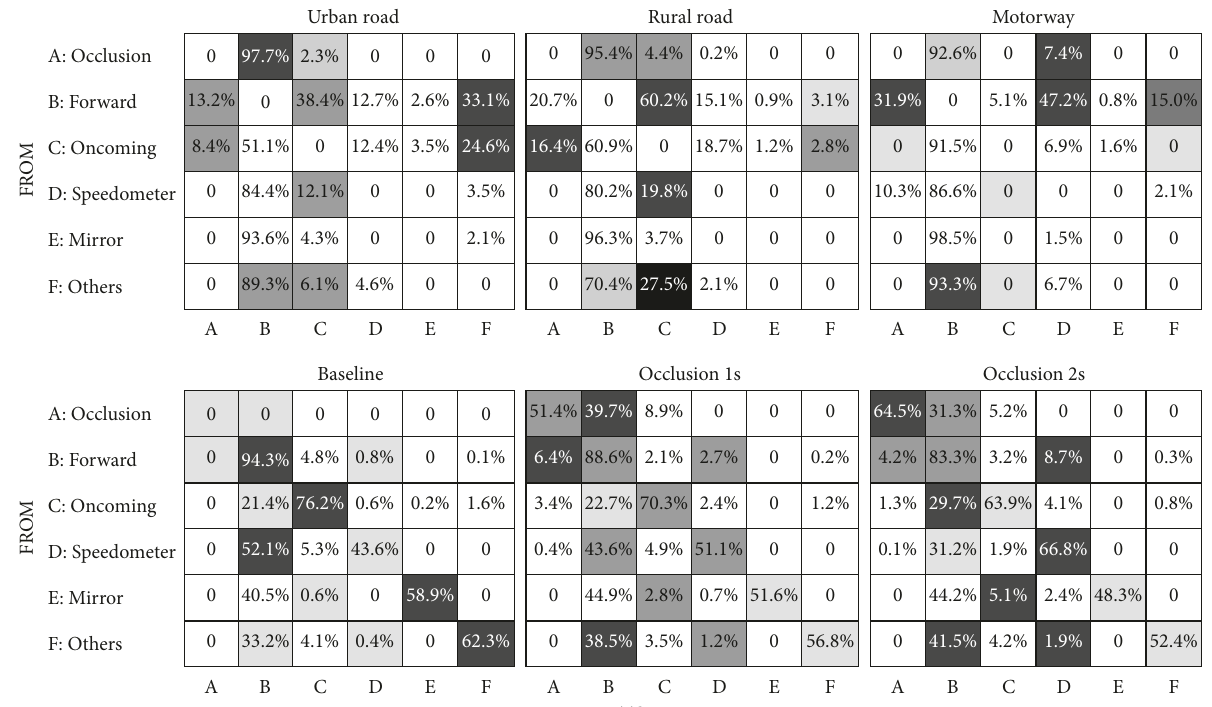
E F TO Figure 4: Glance transition matrices per driving scenarios and eyes-off-road durations. Note that the percentages in each matrix cell present the transition probability, gray cells represent the differences among each condition, and the darker level indicates the higher probability. Rows: (top) driving scenarios and (bottom) occlusion durations.